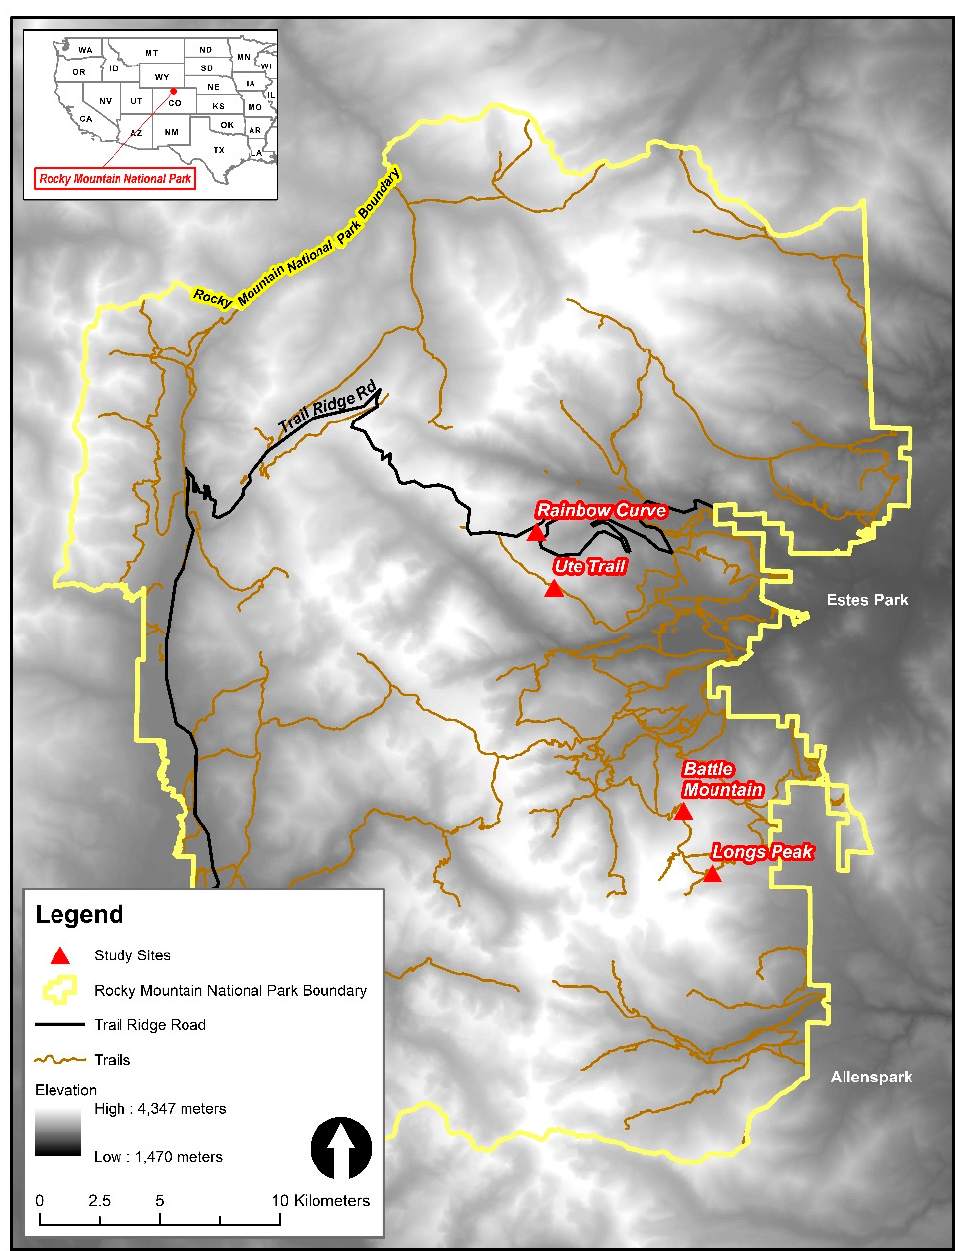
Figure 1. Locations of the four study sites in Rocky Mountain National Park, Colorado, U.S.A., are shown with park trails and roads over a 30 m × 30 m digital elevation model (DEM) of the region. Table 1. Summary information for the four study sites in Rocky Mountain National Park. Study Site Area (ha) Mode Elevation (m) Aspect (s) Prevailing Wind Direction Rainbow Curve 2.74 3376 NW 283 (WNW) Ute Trail 6.62 3472 SE, E 282 (WNW) Longs Peak 8.54 3410 N, NE, E 268 (W) Battle Mountain 3.35 3456 N, NW, W 227 (SW) Aspect, area, and elevation were determined in ArcMap using a 30 × 30 m digital elevation model (DEM). Wind direction was determined by the direction of wind sculpting of tree islands and the table provides the average across islands for each